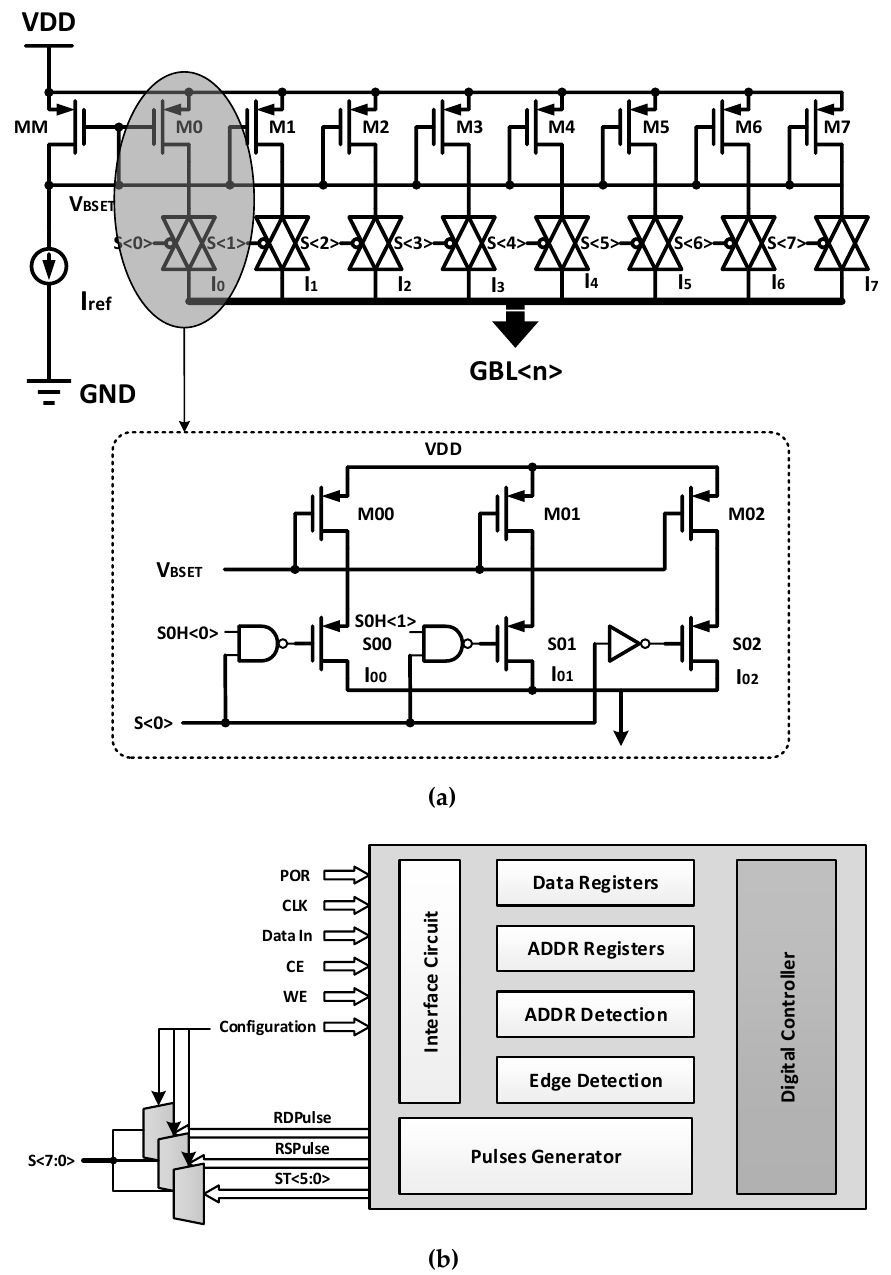
Figure 8. ( a ) Ramp-down current pulse generator circuit; ( b ) control circuit block diagram of the pulse generator.